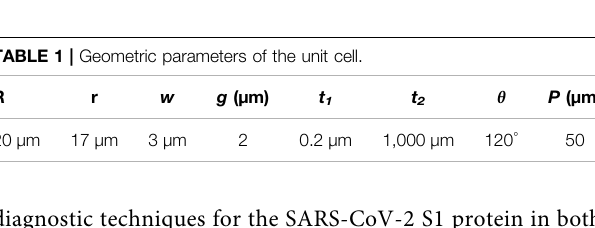
Frontiers in Physics |